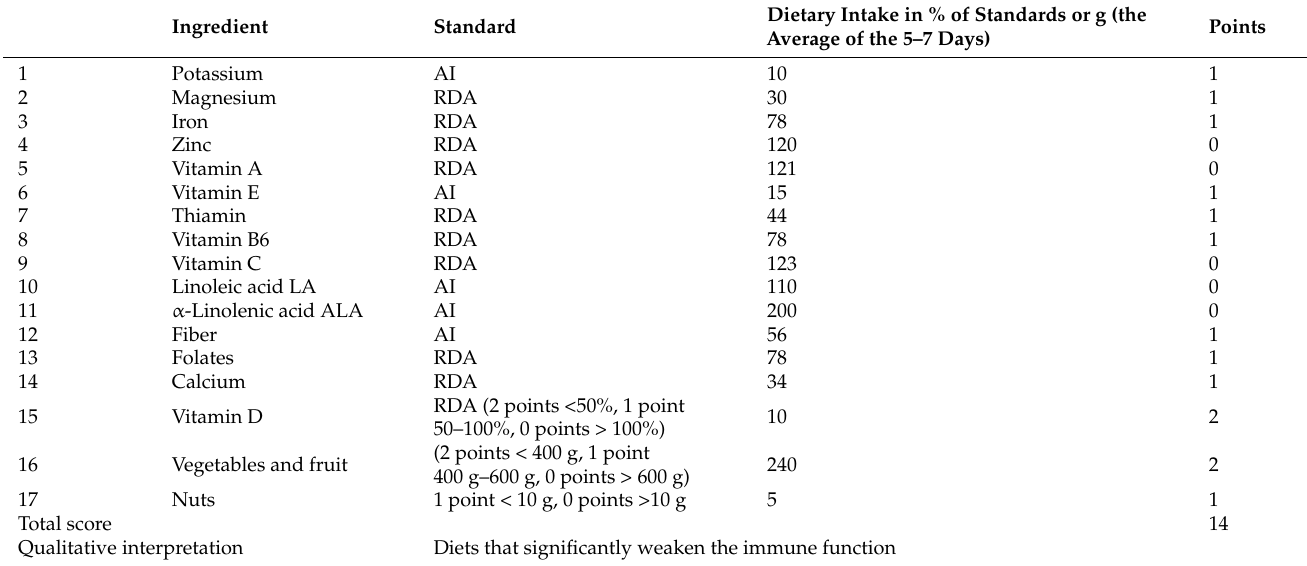
Table 1. Example calculation of the POLA